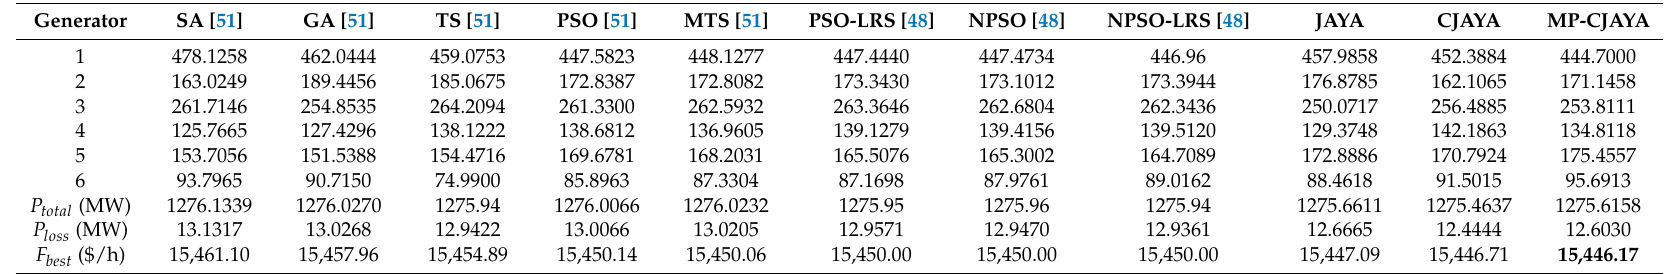
Table 5. Best outputs for 6-units system ( P D = 1263